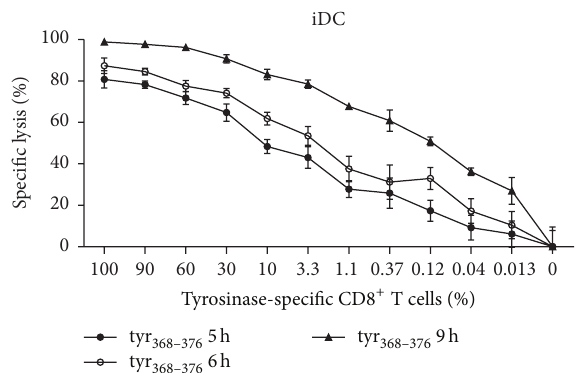
Figure 4: Luciferase IVT RNA electroporation permits a highly sensitive assessment of antigen-specific CTL activity. Titrated amounts of IVSB cells were spiked into PBLs and the specific lysis of autologous iDCs pulsed with the tyr 368 of 20 : 1. Luciferase signals were analysed after increasing coincubation times. Results are the mean ± SD ( 𝑛 = 3 ).